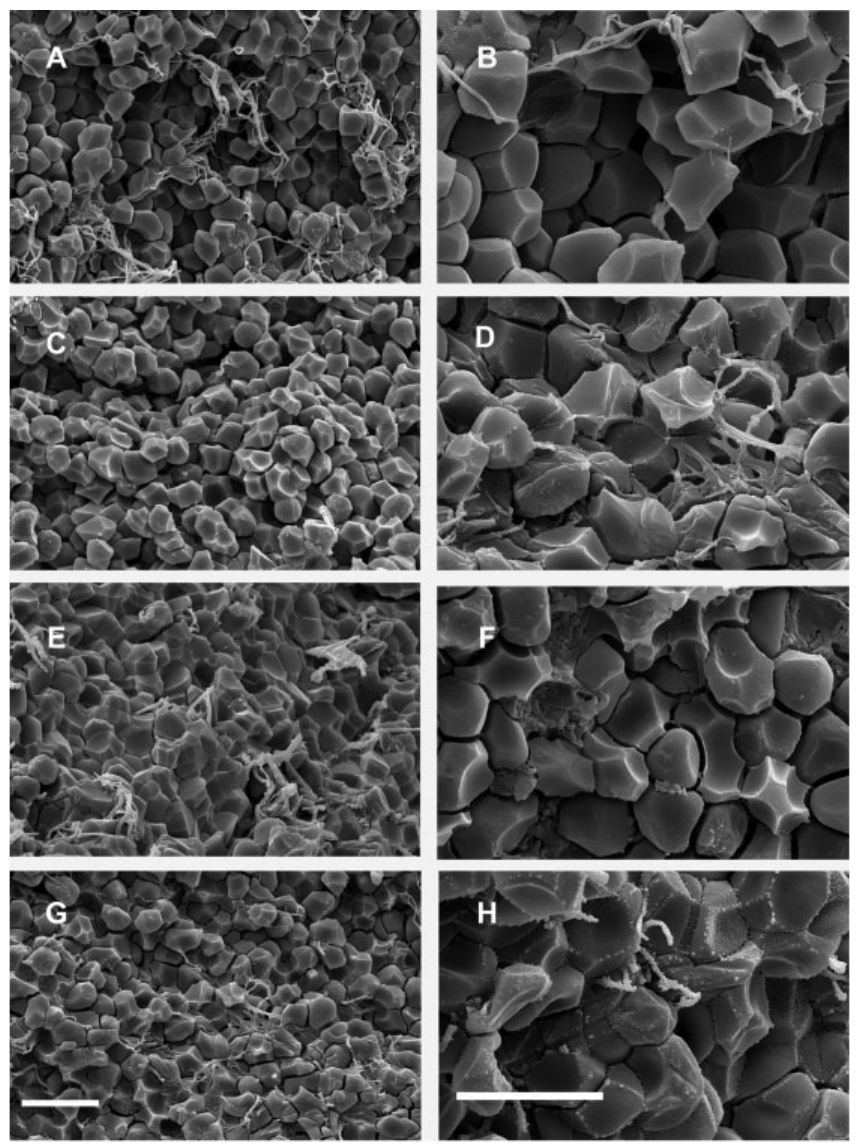
Fig. 2 Representative scanning electron micrographs of the interior of venous thrombi containing compressed polyhedral erythrocytes (polyhedrocytes) as a morphologic signature of contraction in vivo. The corresponding images were taken from four randomly selected thrombi at lower ( A , C , E , G ) and higher magni fi cation ( B , D , F , H ). Magni fi cation bars ¼ 10 µm. TH Open Vol. 2 No.